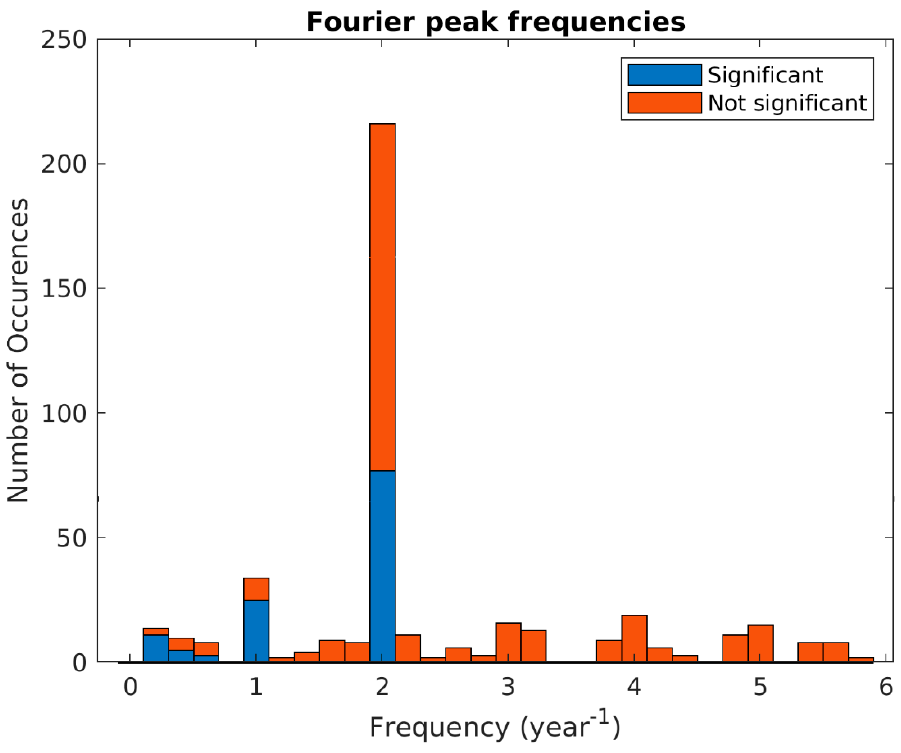
Figure 13. ( Left ): The frequency of the secondary peak from the FFT for each LO range-azimuth cell. ( Right ): the amplitude of the second largest peak from the FFT for each LO range-azimuth cell . Range-azimuth cells with greater than 50% missing data are excluded from the Fourier analysis.